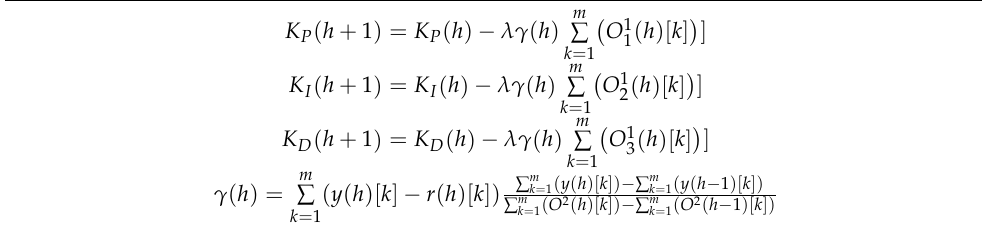
Table 3. Specified weight learning algorithm for auto-tune classical PID